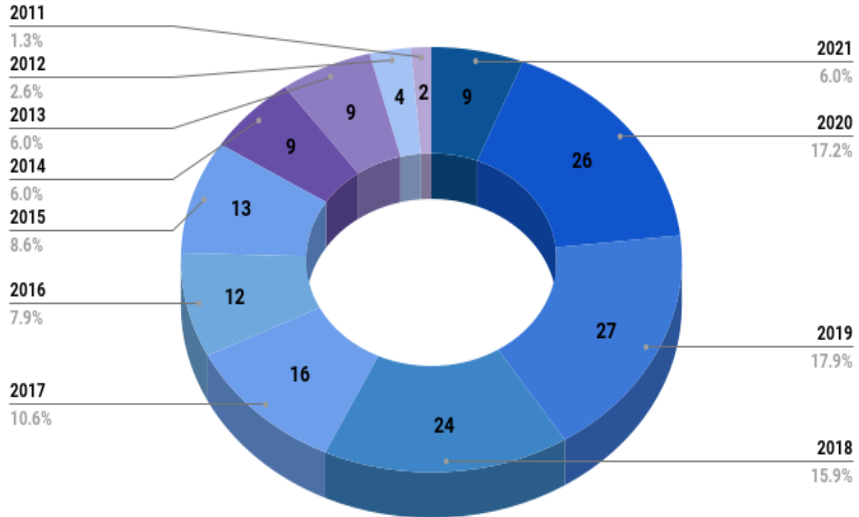
Figure 2. Distribution of studies in terms of year of publication (2011 – 2021).